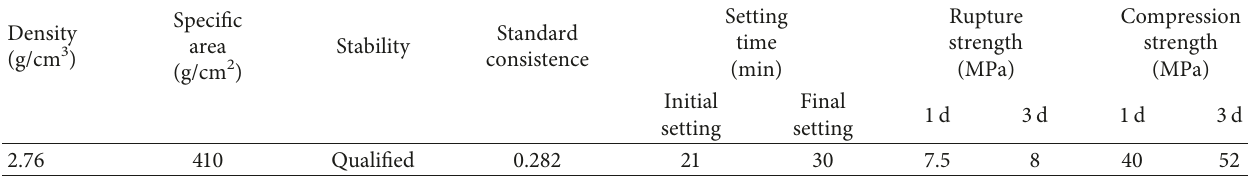
Table 1: Physical properties index of cement.